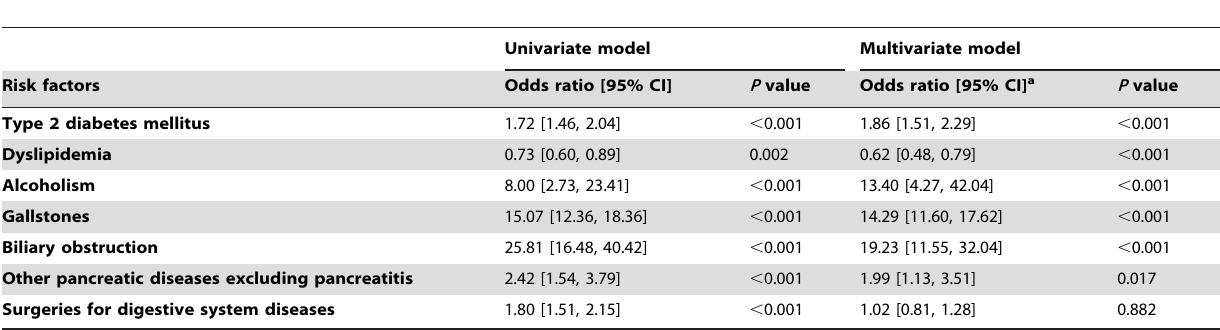
Table 4. Univariate and multivariate conditional logistic regression for estimating acute pancreatitis risks in case-control